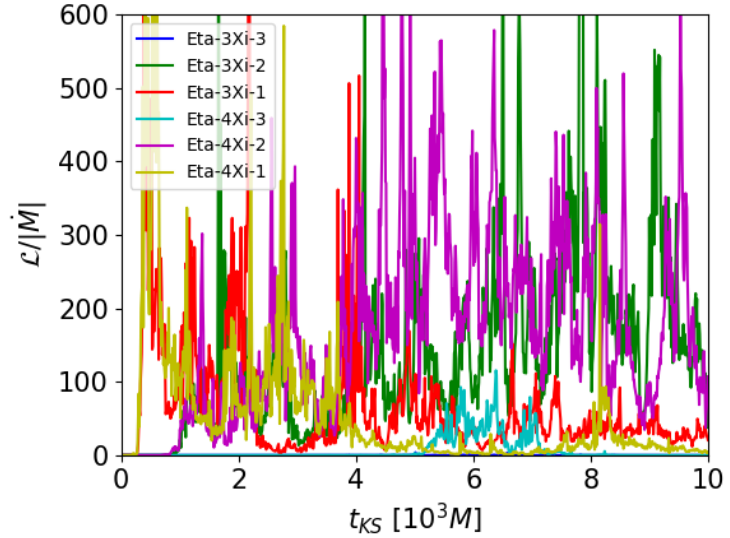
Figure 7. Time evolution of the pseudo-luminosity for each model. In runs with strong and interme- diate dynamo, we see more noise than simulations of Porth and EHT-Collaboration